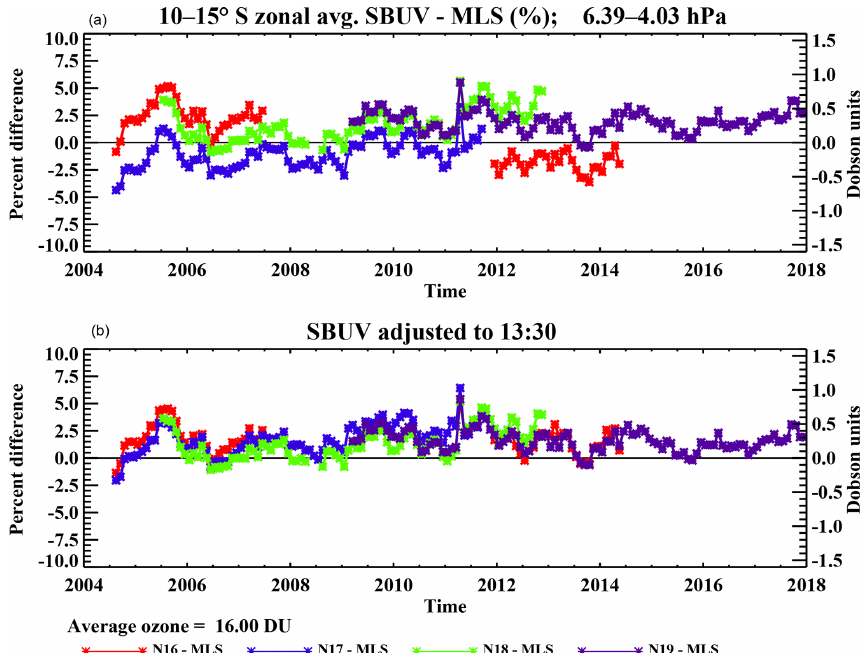
Figure 10. Time series of NOAA-16–NOAA-19 SBUV zonal mean data relative to Aura MLS from 2004 to 2018 in the 10–15 ◦ S latitude band and 6–4hPa pressure layer. Panel (a) shows the original differences, and panel (b) shows the differences after individual SBUV instruments have been adjusted to a common time of 13:30LST, to coincide with the Aura MLS measurement time. Monthly zonal means of both SBUV and MLS are well sampled such that the uncertainty of 2SEM is smaller than the plot symbols.